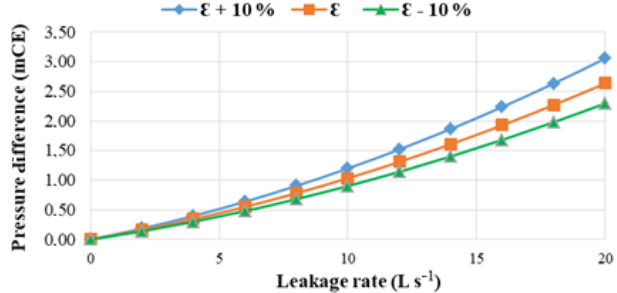
Figure 5. Influence of the error on the roughness of the pipe.